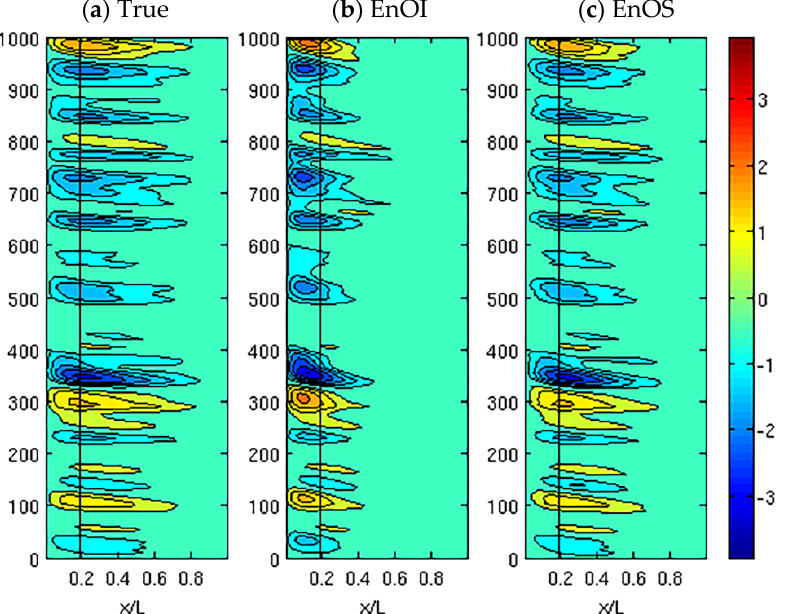
Figure 1. Hovmöller diagrams of stream function predicted by the forced Rossby wave model. In each panel, the horizontal axis shows the zonal position ( x ) scaled by the width of the ocean ( L ) and the vertical axis shows the time from 0 to 1000 days. ( a ): stream function resulting from white noise forcing; ( b ): analyzed stream function based on assimilating perfect observations x / L = 0.2 when using EnOI and no forcing; ( c ): As for the central figure observations, but assimilated using EnOS with lags of 0 and 1 time steps of the model.